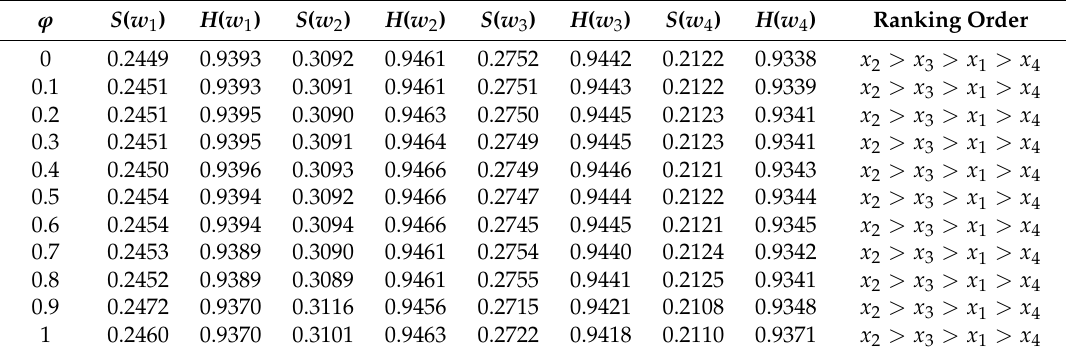
Table 1. Computation results and ranking orders for different values of parameters ϕ with MCI 0 = 0.1